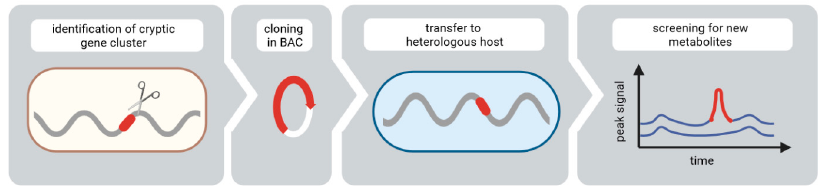
Figure 1. General workflow for compound discovery using heterologous expression.